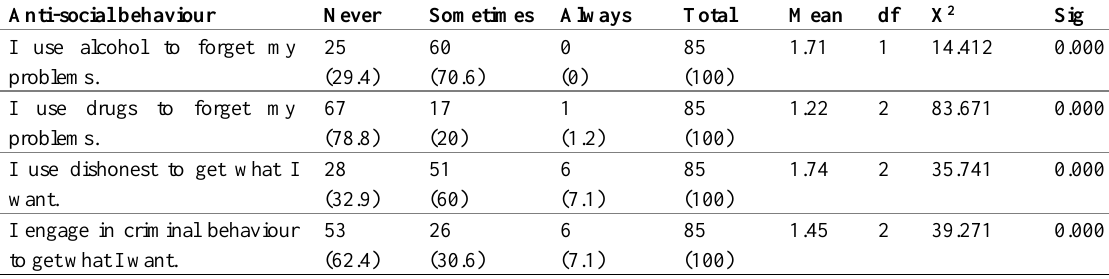
Table 3: Anti-social behaviour of the unemployed people